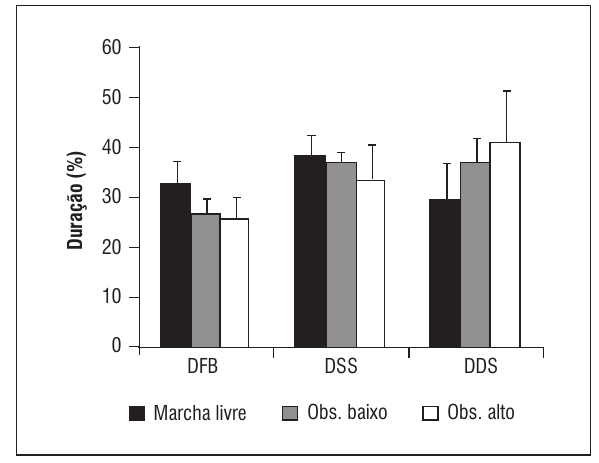
Figura 2 - Médias e desvios padrão da duração da fase de balanço (DFB), duração do suporte simples (DSS) e duração do duplo suporte (DDS) nas condições de marcha livre e na fase de aproximação do obstáculo baixo e do obstáculo alto Fonte: Dados da pesquisa.